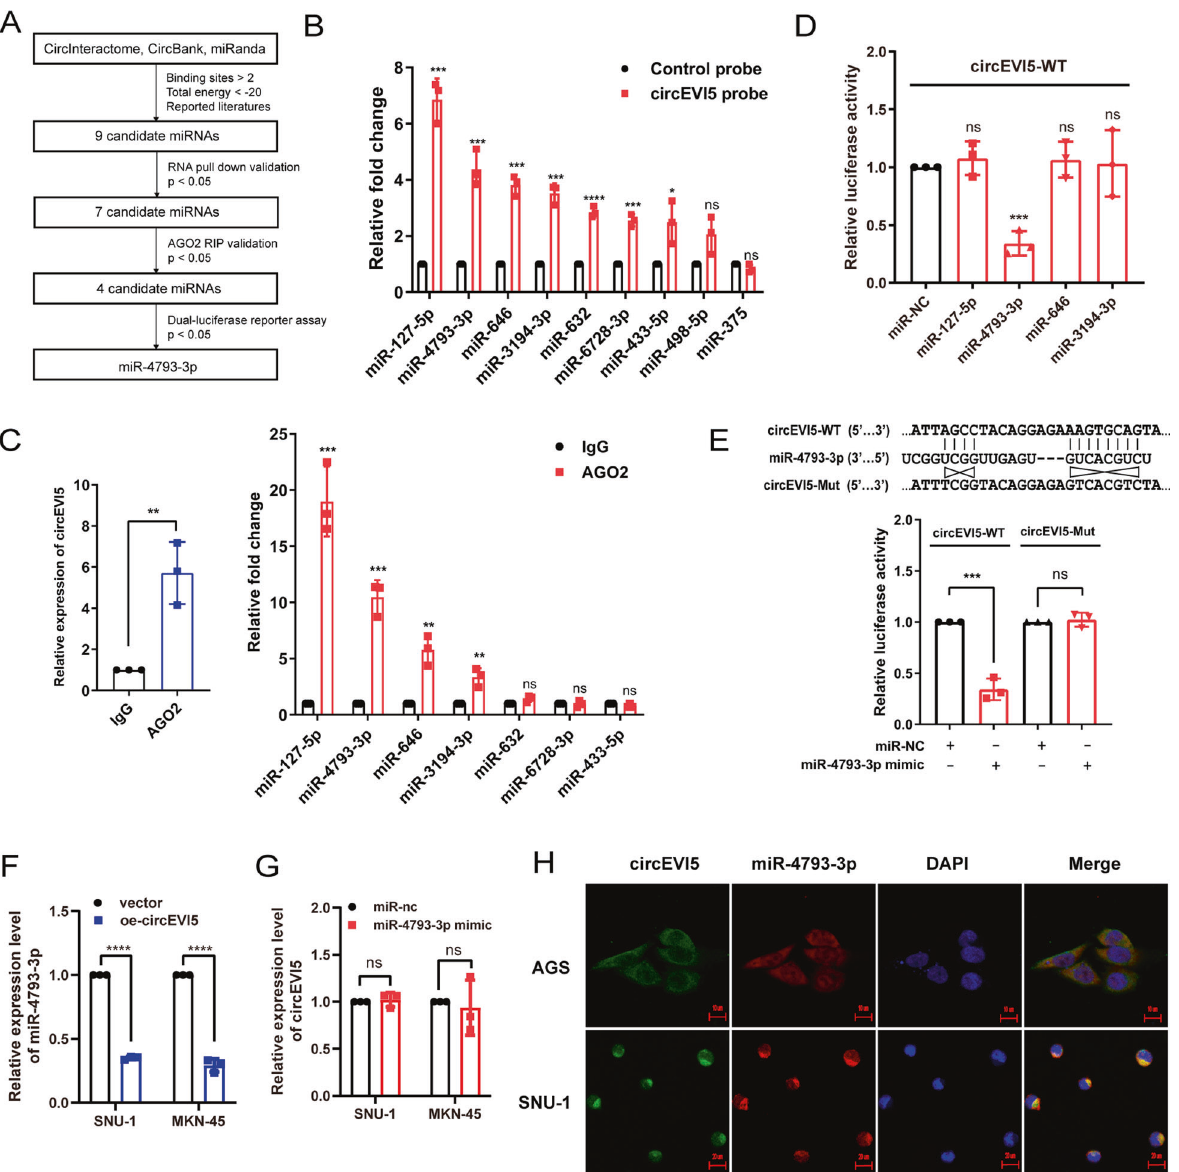
Fig. 3 circEVI5 served as a miR-4793-3p sponge. A The fl ow chart illustrated the screening criteria of identifying miR-4793-3p as the target of circEVI5. (The lower energy value indicates that higher energy is required for the disassembly of the miRNA-circRNA interaction, indicating a more reliable conjugation relationship.) B QRT-PCR con fi rmed the enrichment of miRNAs pulled down from the circEVI5 probe. miR-127-5p, miR-4793-3p, miR-646, miR-3194-3p, miR-632, miR-6728-3p, and miR-433-5p were statistically signi fi cant enriched ( p < 0.05). C The RIP assay was executed to detect circEVI5 and miRNAs captured by anti-AGO2. miR-127-5p, miR-4793-3p, miR-646, and miR-3194-3p were statistically signi fi cant enriched ( p < 0.01). D The relative luciferase activities were detected in HEK-293T cells after co-transfection with circEVI5-WT dual- luciferase reporter and miR-127-5p, miR-4793-3p, miR-646 or miR-3194-3p mimics, respectively. E The relative luciferase activities were detected in HEK-293T cells after co-transfection with circEVI5-WT or circEVI5-Mut dual-luciferase reporter and miR-4793-3p mimics or miR-NC, respectively. F The expressions of miR-4793-3p were analyzed by using qRT-qPCR in cells transfected with circEVI5 or control vector. G The expression levels of circEVI5 were determined with qRT-qPCR in cells transfected with miR-4793-3p mimics or miR-NC. H The FISH assay was performed to observe the colocalization of circEVI5 (green) and miR-4793-3p (red) in the cytoplasm, and nuclei were stained with DAPI (blue). Scale bars, AGS: 10 μ m, SNU-1: 20 μ m. Data were shown as the mean ± SD of three independent experiments. * p < 0.05, ** p < 0.01, *** p < 0.001, **** p < 0.0001. Meier analysis showed that GC patients with high miR-4793-3p miR-4793-3p can reverse the repression function of circEVI5 in expression had a shorter RFS (Fig. 4B), indicating miR-4793-3p GC cells may act as a tumor suppressor and high miR-4793-3p predicts a Based on the interaction between circEVI5 and miR-4793-3p, we poor prognosis in GC. Pearson correlation analysis showed that next evaluated the potential functional roles of miR-4793-3p by the expression level of circEVI5 negatively correlated with miR- transfecting miRNA mimics or inhibitors into SNU-1 and MKN-45 4793-3p in GC tissues ( p < 0.01) (Fig. 4C). To further determine cells. The CCK-8 assay indicated that miR-4793-3p could whether circEVI5 exerts its biological function by sponging miR- promote the proliferation of GC cells (Fig. 4A) and the Kaplan-